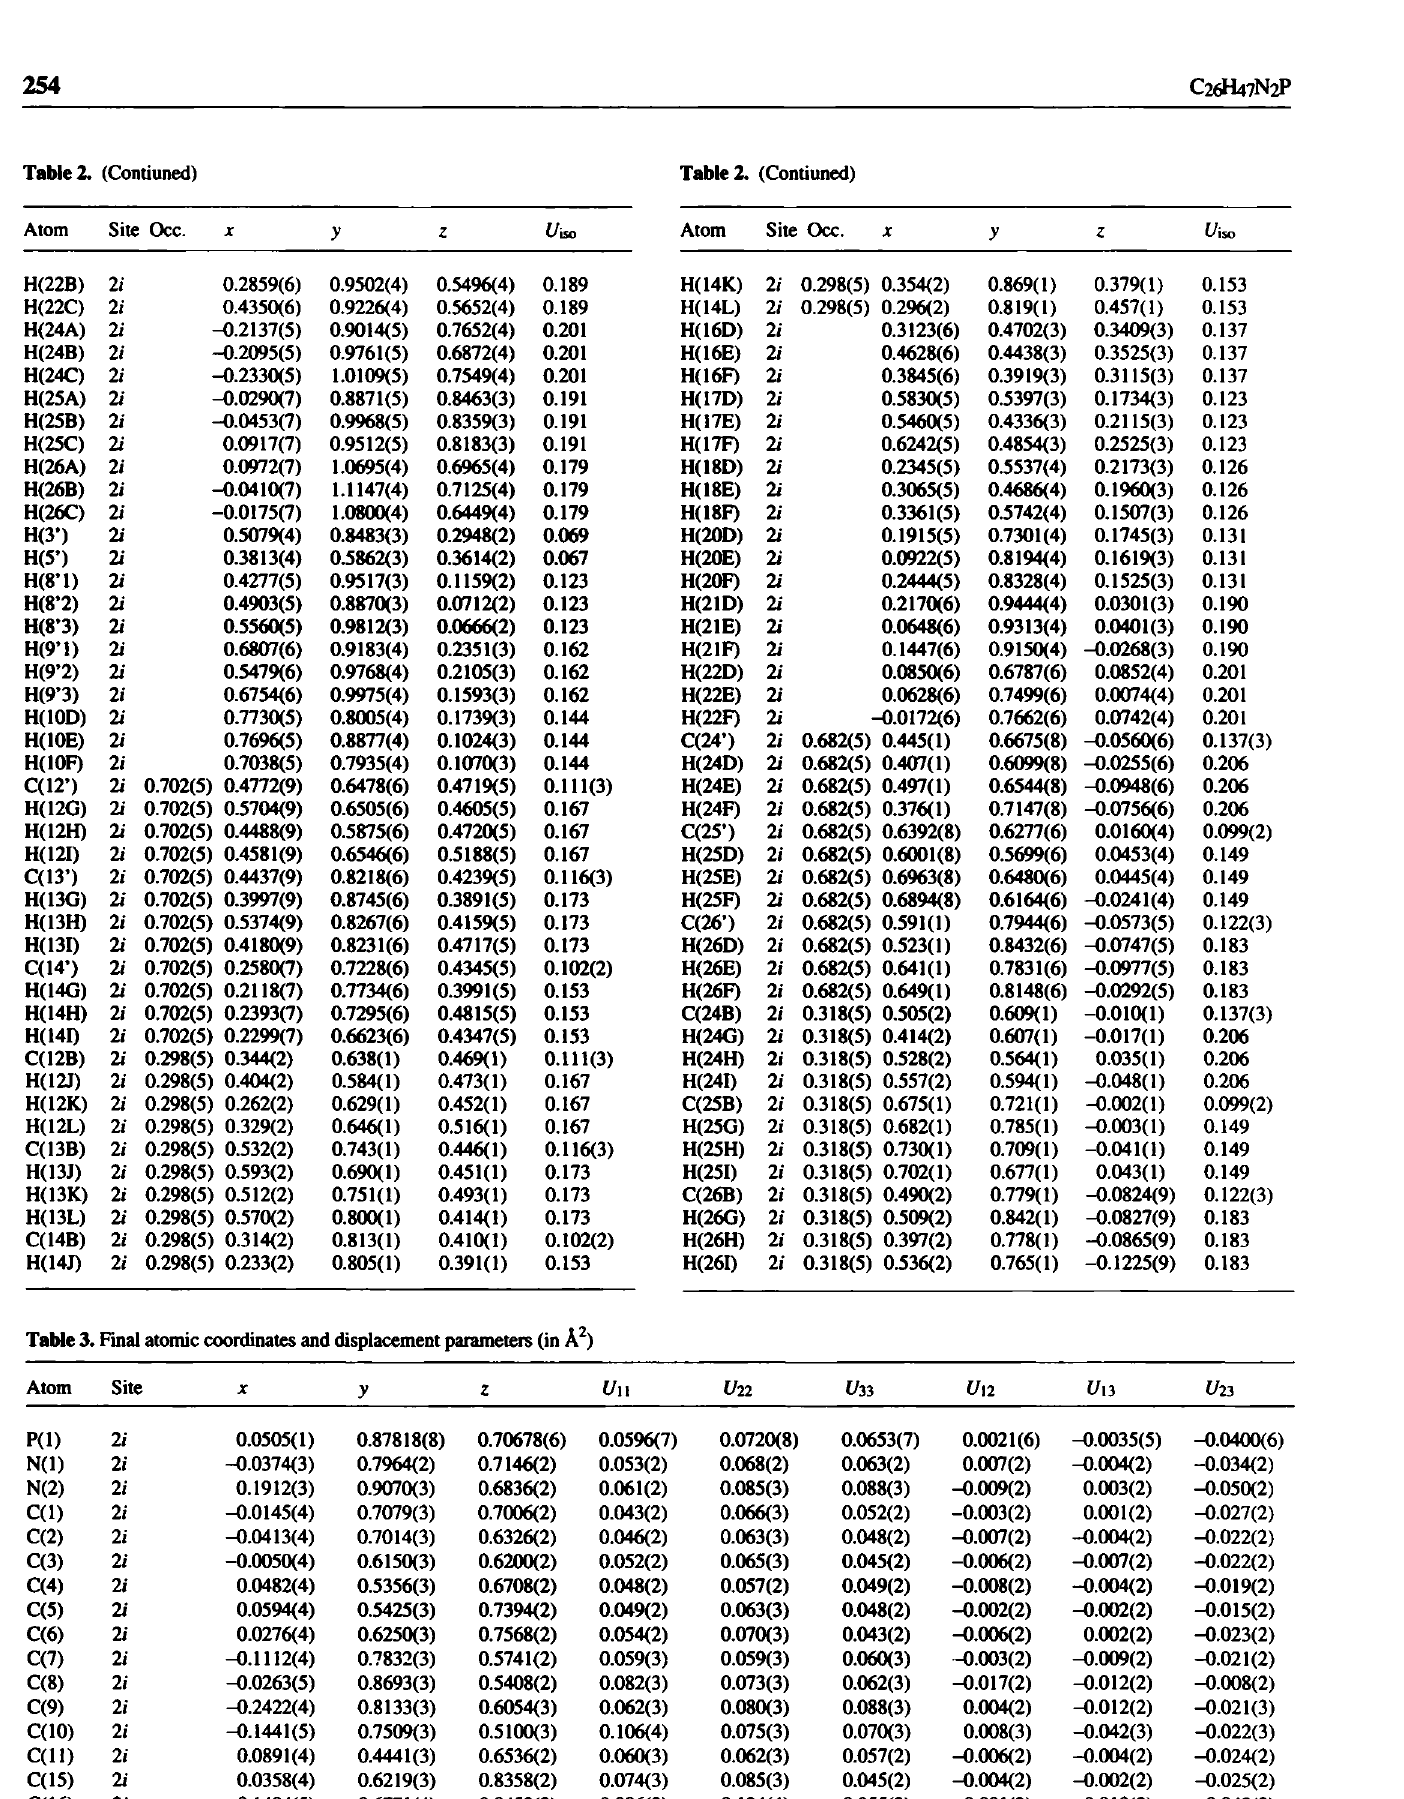
Table 3. Final atomic coordinates and displacement parameters (in Â 2